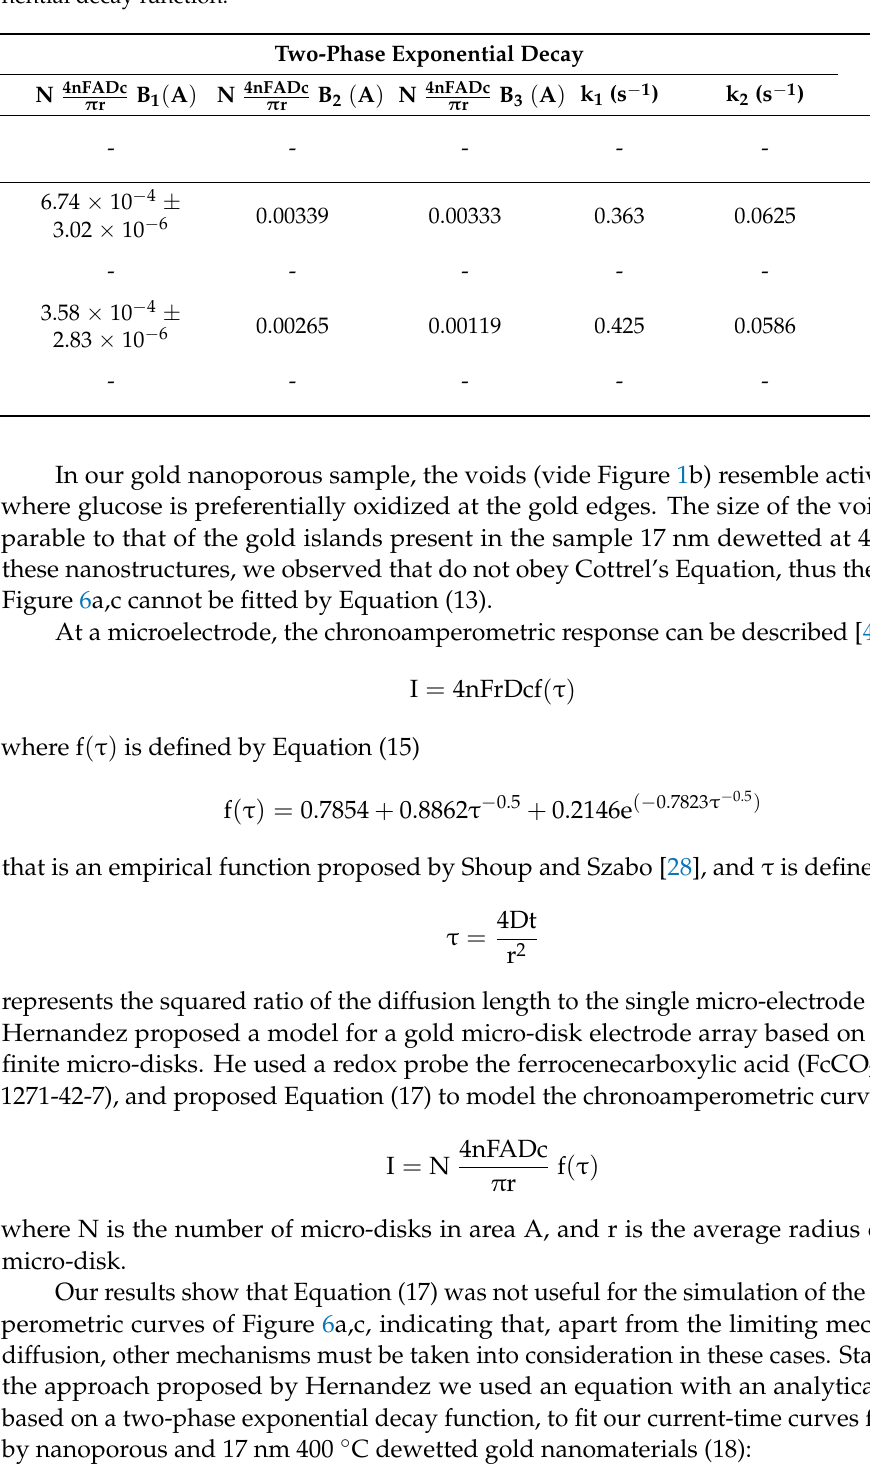
Table 1. Parameters used for the simulation of current-time curves by Cottrel and two-phase expo- nential decay